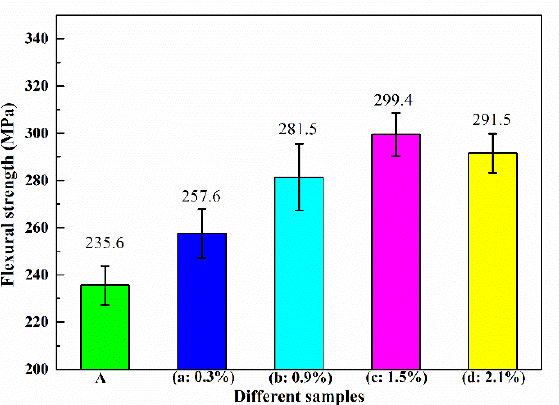
Figure 7. Bending strength of strain-stress curve of the samples: (A) is the blank samples; and (a–d) are the 0.3 – 2.1% resin-added samples.